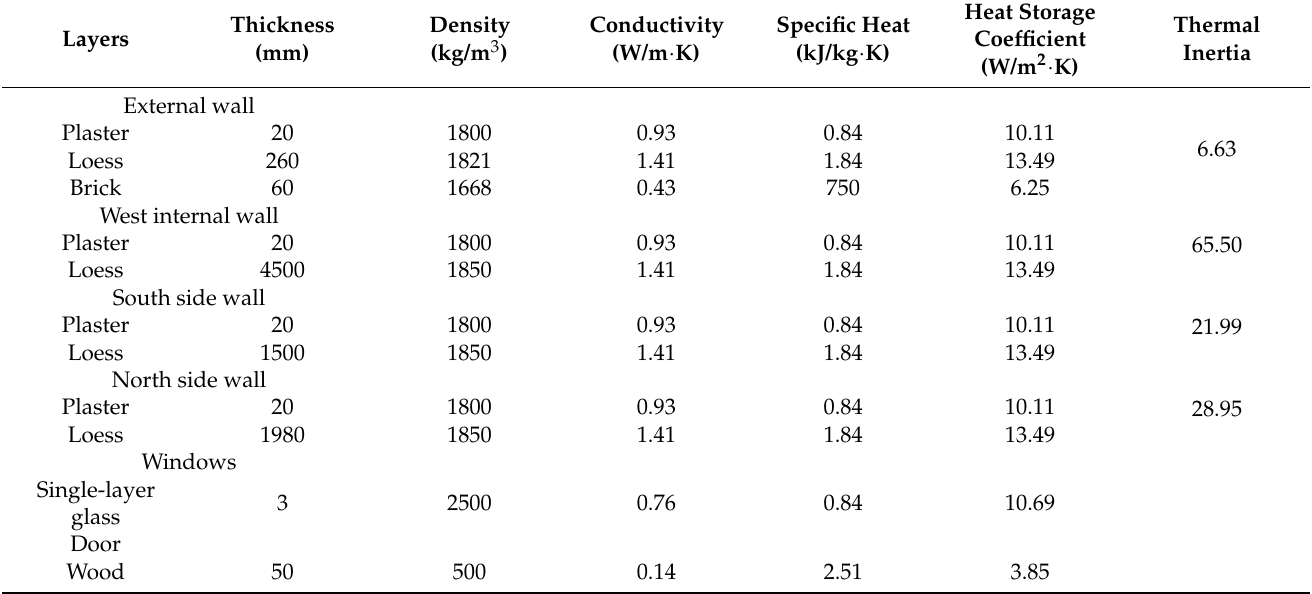
Table 1. Thermal properties of envelopes.